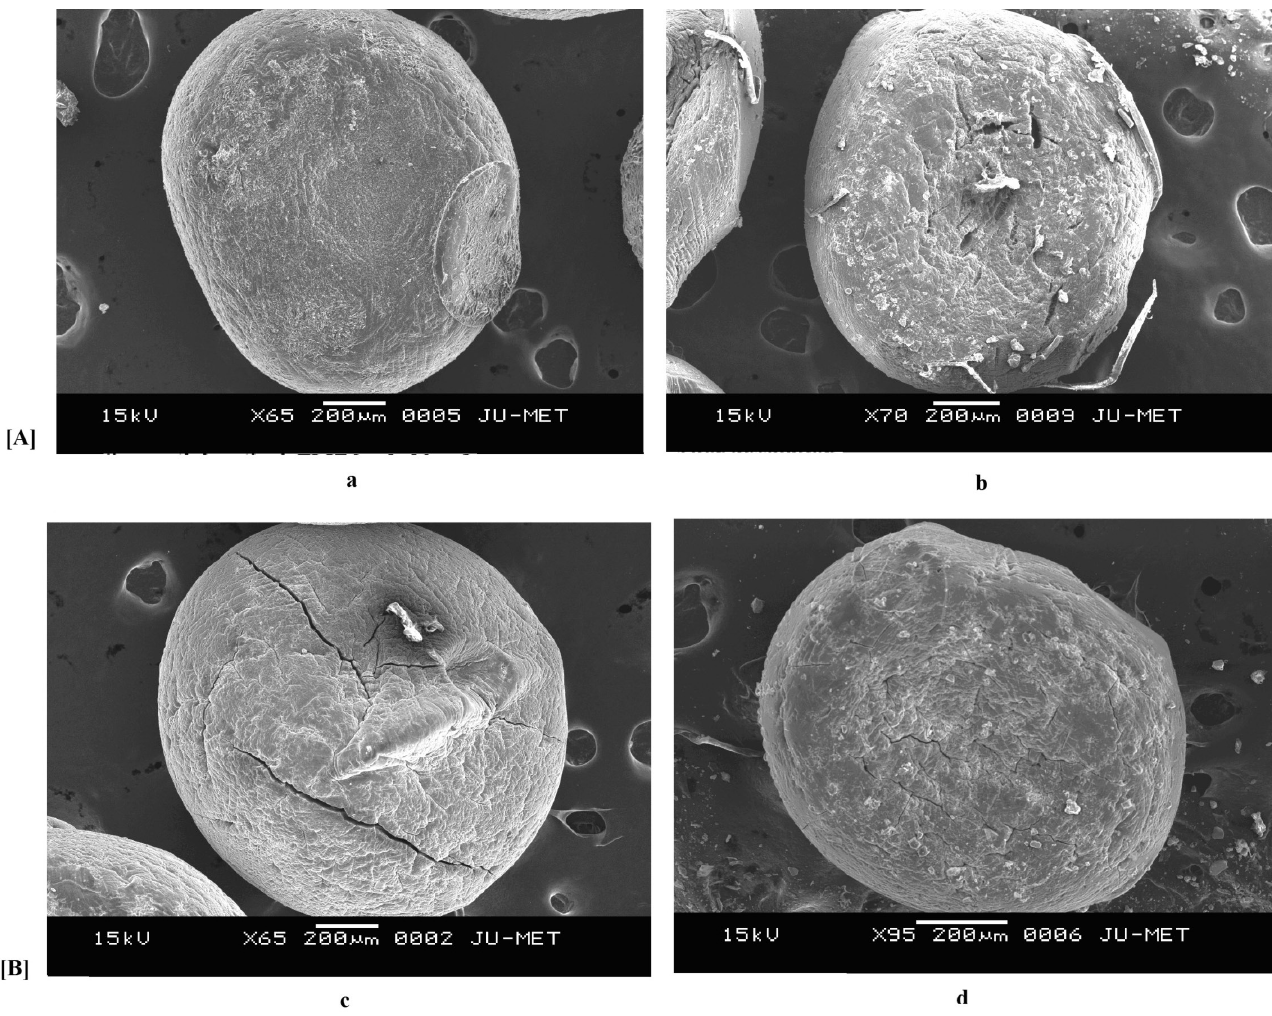
FIGURE 1 - [A] SEM photographs of TMZ-loaded calcium alginate beads prepared by the sequential method (a) Drug-loaded bead (b) After dissolution. [B] SEM photographs of TMZ loaded calcium alginate beads prepared by simultaneous method (c) Drug-loaded bead (d) after